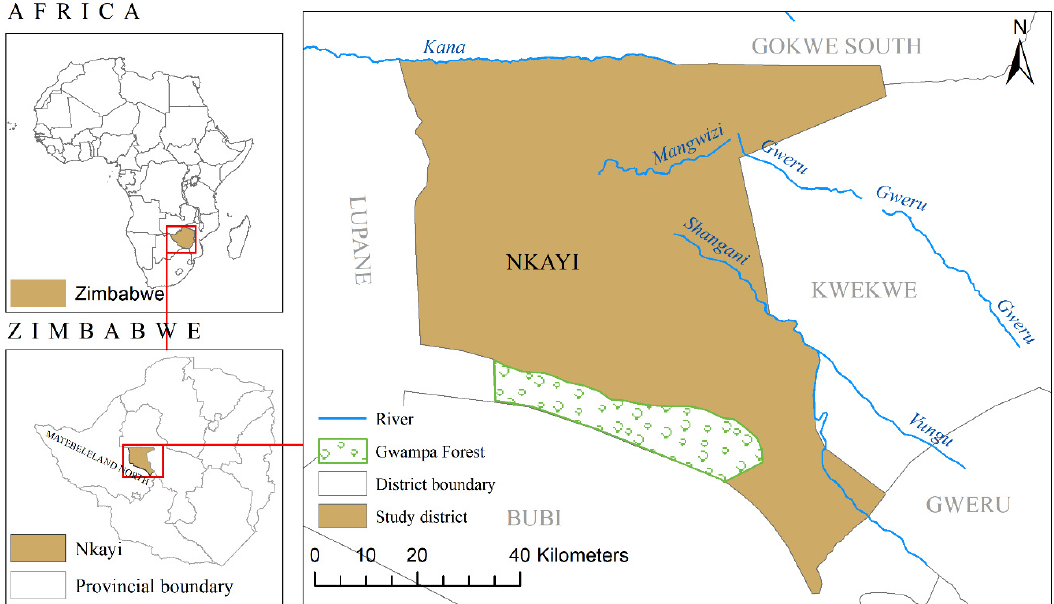
Figure 1. Location of Nkayi district in Matebeland north province of Zimbabwe (Data source: International Crop Research Institute for the Semi-Arid Tropics (ICRISAT)).